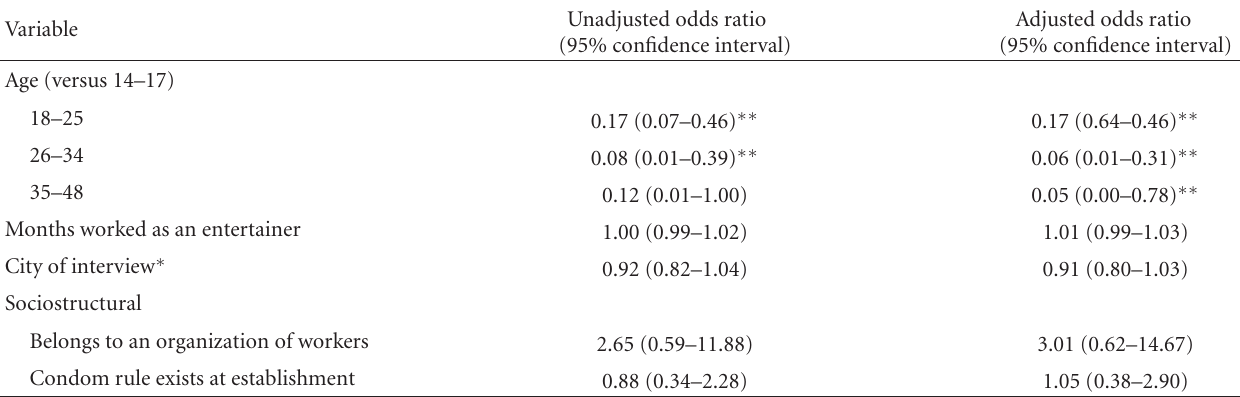
Table 3: Associations between FSW age and perceived manager safer sex advice if a client refuses condoms in the southern Philippines ( N = 791) ∗